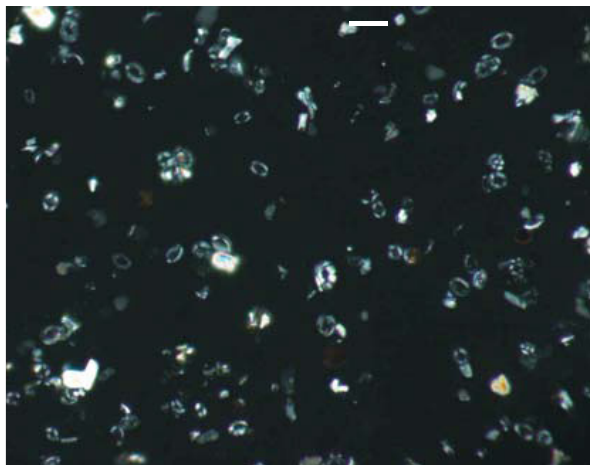
Figure 3. Cross-polarised microphotograph of Lower Toarcian black shales exposed at Bascharage – sample from the Schistes car- ton Formation at 6m in this section. This image illustrates the good preservation state of coccoliths and the reduced abundance of diage- netic particles (scale bar: 10µm). Microseparated assemblage taken from Minoletti et al.